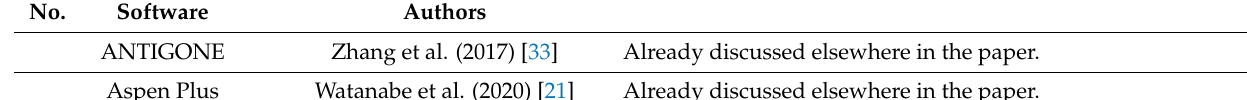
Table 5. Modeling and optimization software used in previous research and case